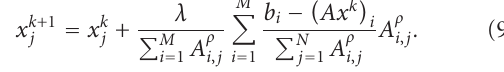
Figure 2: Comparison of the two main cases, when a profile corre- sponding to a large and homogeneous structure is measured with noise (a), and when the measured profile corresponds to a higly detailed object (b). On (a), using all the discrete measurements of voxel’s PSF will smooth the reconstruction which will reduce the noise. On (b), “important” high frequencies are smoothed and more iterations will be needed to achieve an accurate reconstruc- tion.